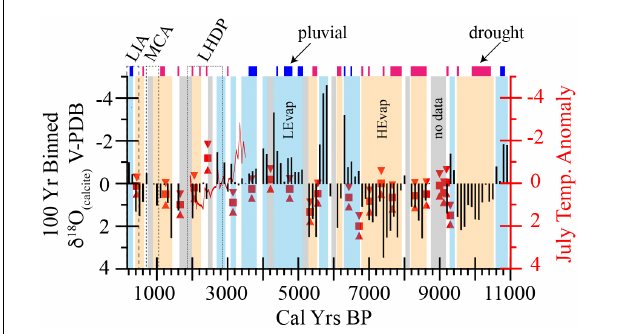
FIGURE 11 | 100-year binned δ 18 O ( calcite ) values versus the pollen July temperature anomaly reconstruction (July temperature axis is inverted) from the San Jacinto Mountains (Wahl, 2003; Ohlwein and Wahl, 2012). Inverted triangles represent the one-sigma range associated with the temperature reconstruction (Wahl, 2003; Ohlwein and Wahl, 2012). Intervals of shared δ 18 O ( calcite ) values and sand drought are shown by dark red boxes and vice versa for pluvials (dark blue boxes) at the graph. LEvap, low evaporation; HEvap, high evaporation; LIA, Little Ice Age (Masson-Delmotte et al., 2013); MCA, Medieval Climatic Anomaly (Masson-Delmotte et al., 2013); Late Holocene Dry Period (Mensing et al.,